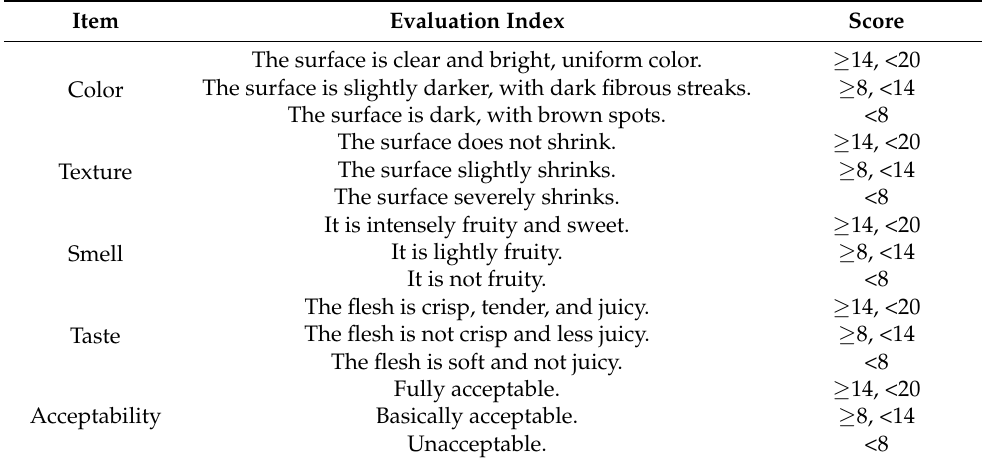
Table 1. Indexes for the sensory evaluation in fresh-cut apples.